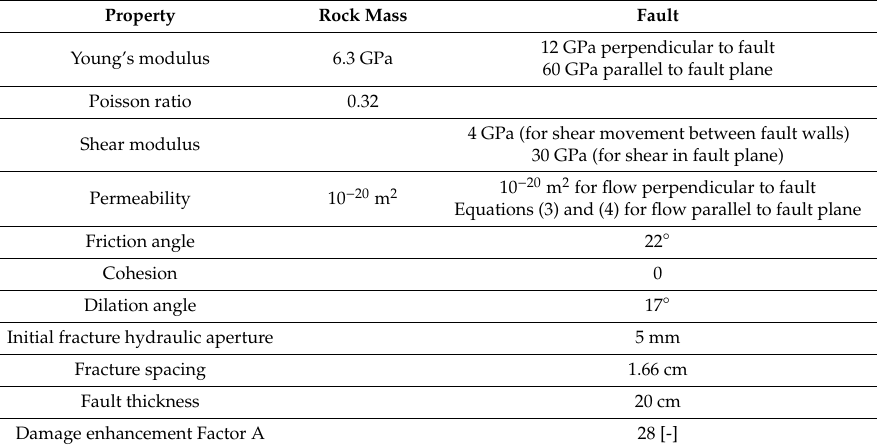
Table 1. Assumed input properties.